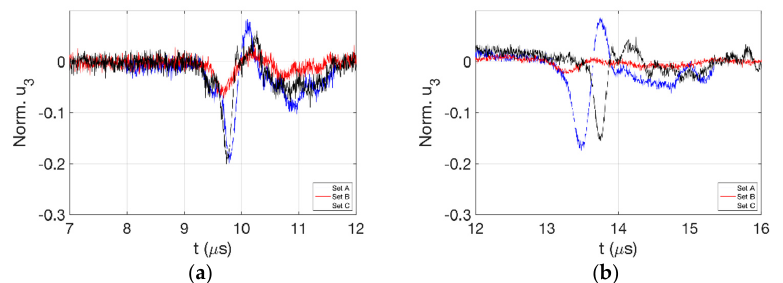
Figure 11. Ti-6Al-4V AM depositions for process parameter sets A, B, C in Table 1 received at ( a ) point 1 and ( b ) point 2.